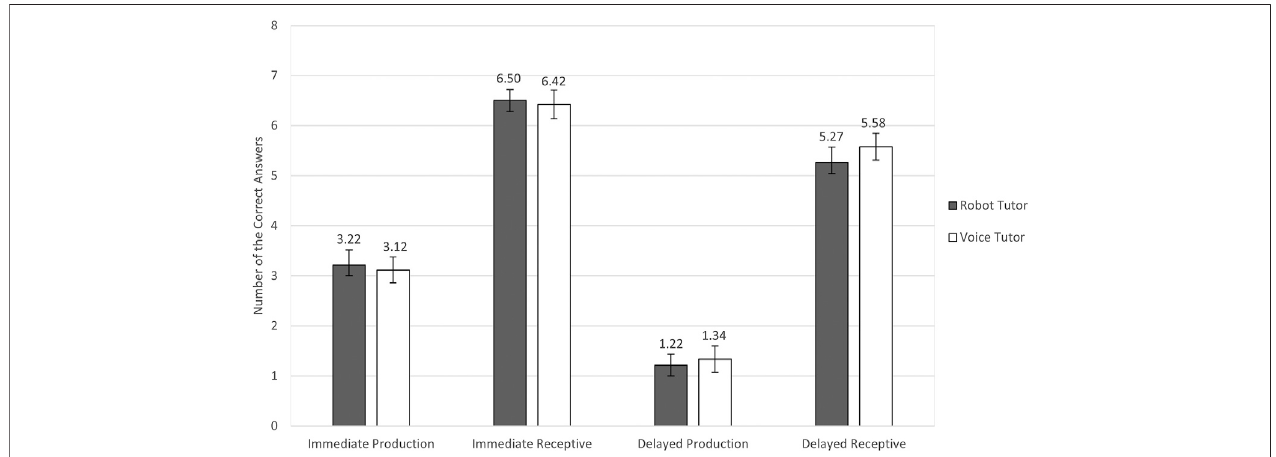
FIGURE 3 | Mean number of correct answers in the robot tutor and voice tutor conditions in the four post-lesson tests. N (cid:1) 100 for the immediate production and receptive tests; N (cid:1) 99 for the delayed production and receptive tests. The highest possible score for each test was eight. The error bars indicate the standard errors.